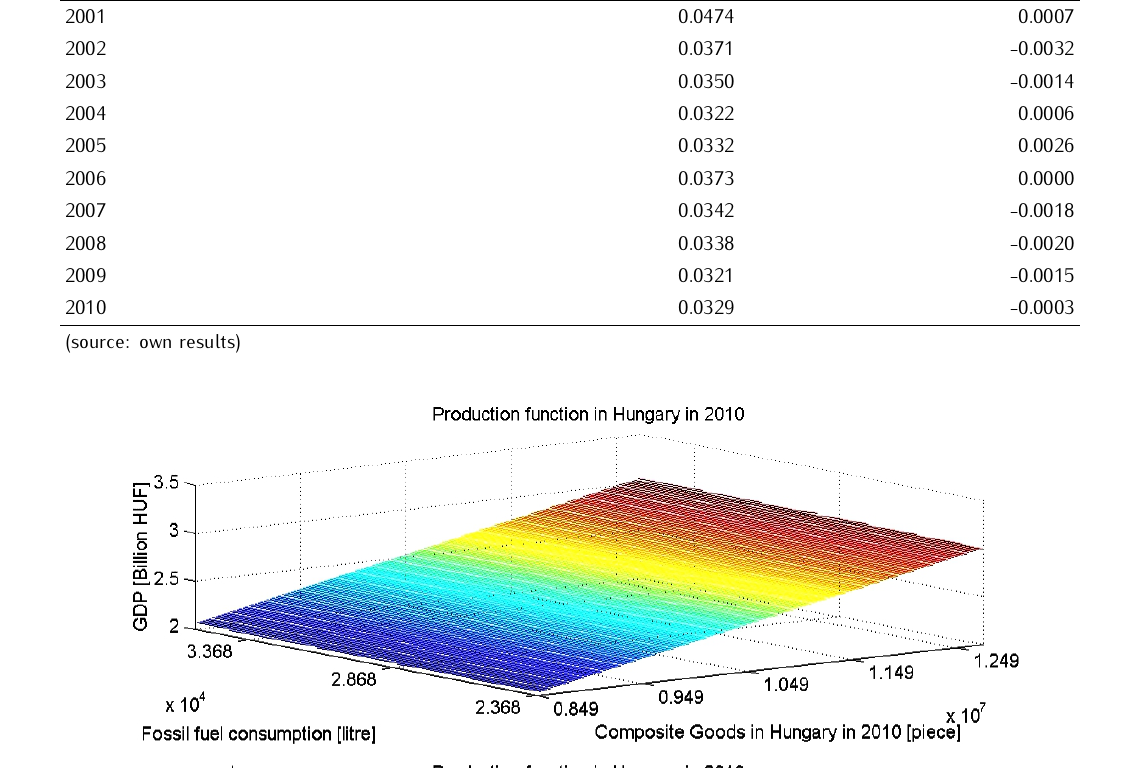
between soft measures on emissions in road transport and their effect on economy for the technical level, which is considered constant. As the technical level is considered constant in the model and the emission lowering actions led us to decreasing economic activity that means that